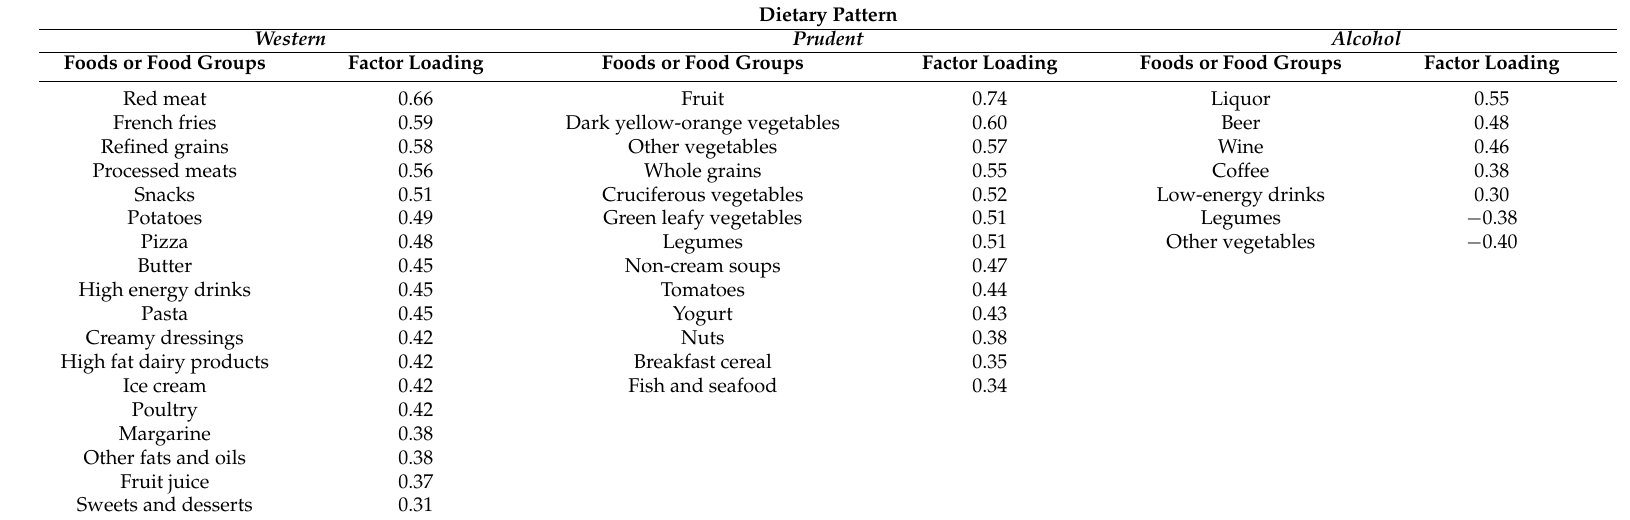
Table 2. Factor loading matrix for the three major dietary patterns identified from the Food Frequency Questionnaire (FFQ).